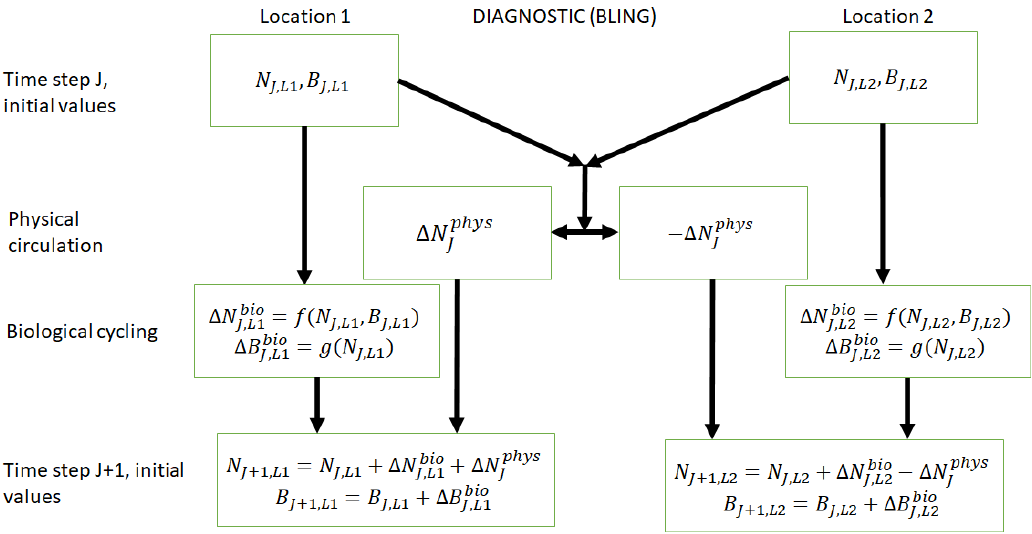
Figure 1. Conceptual diagram of how biogeochemical evolution is computed within an ESM using the BLING BC. The letters and abbrevi- ations represent nutrients ( N ), phytoplankton biomass ( B ), the physical circulation component (phys), and the biological cycling component (bio). Each location has initial values for nutrients and biomass. These initial values are passed to the intrinsic biological relationships, which then feed into the g function in the biological cycling boxes that are then used to calculate the changes in nutrients and biomass due to biological cycling. The initial nutrient concentrations between the two locations result in a change in nutrients from physical transport, which is equal in magnitude and opposite in sign between the two boxes (physical circulation component). When the physical circulation and biological cycling portions are coupled together, the nutrients and biomass for the next time step are calculated.